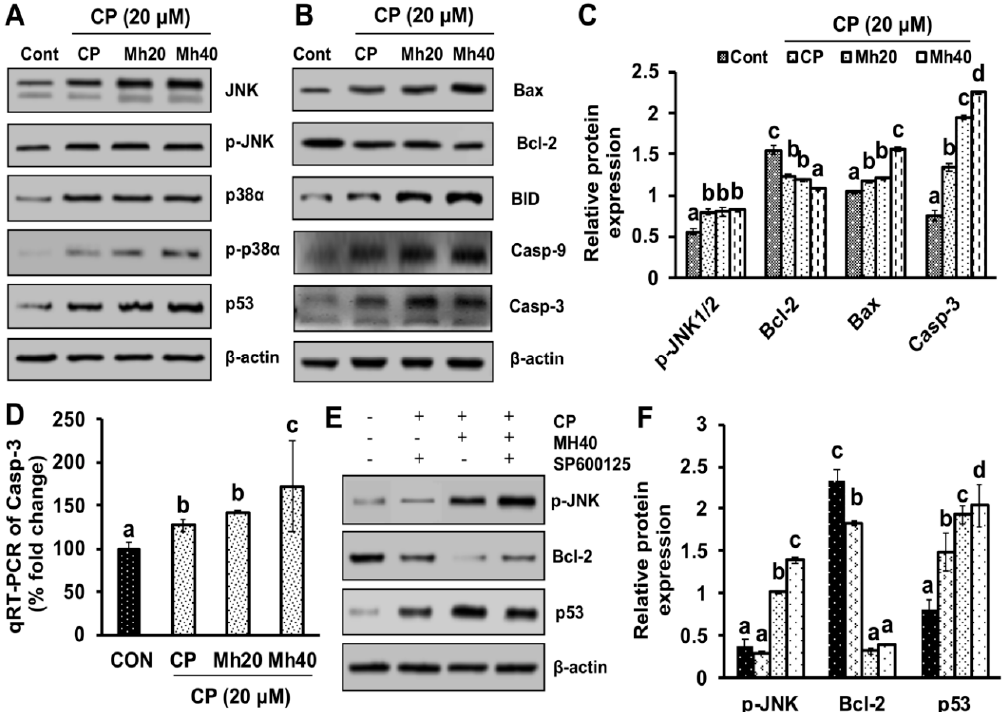
Figure 4. Apoptosis induction in HepG2 cells after CP and CP-Mh treatment. ( A ) Apoptosis signaling markers, including JNK, p-JNK, p38 α , p-p38 α and p53 were analyzed by Western blotting, results are normalized with β -actin. ( B ) Pro-apoptosis markers, including Bax, Bcl-2, BID, Casp-9 and Casp-3 were analyzed by Western blotting. Results are normalized to β -actin in respect to controls. ( C ) Relative protein expression of p-JNK, Bcl-2, Bax and Casp-3 analyzed by densitometry analysis using ImageJ software. ( D ) Quantitation of Casp-3 mRNA level by qRT-PCR after corresponding drug treatment in HepG2 cells. ( E ) Apoptosis signaling markers including p-JNK, Bcl-2 and p53 after corresponding drugs and SP600125 treatment were analyzed by Western blotting. Results are normalized with β -actin in respect to controls. ( F ) Relative expression of protein was calculated by densitometry analysis using ImageJ software. The data are represented as the means standard deviation (±SD, n = 3). The values of different letters (a–d) differ significantly from each other ( p < 0.05).